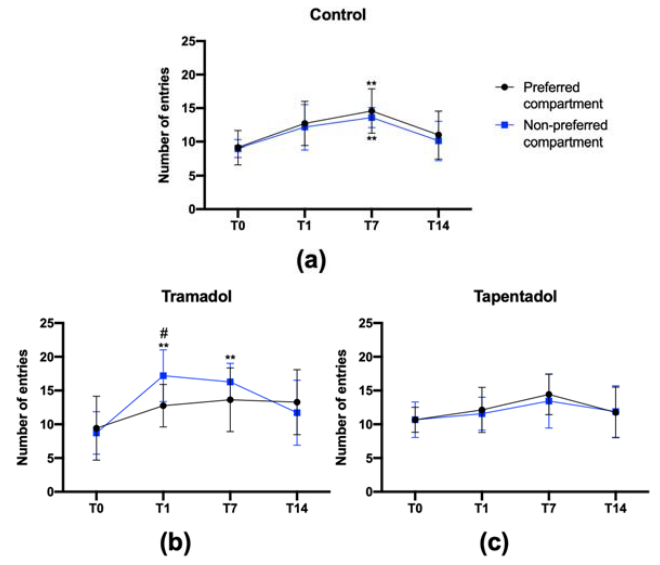
Figure 3. Number of entries in each compartment (preferred (saline-paired) compartment and non- preferred (drug-paired) compartment) at each time point—preconditioning phase (T0), and 1, 7 and 14 days after the last drug administration (T1, T7 and T14, respectively). In the conditioning phase, rats received daily intraperitoneal injections of 50 mg/kg tramadol ( b ) or tapentadol ( c ), alternating with normal saline, for 8 days. Control animals received daily intraperitoneal injections of normal saline for the same period ( a ). Results were recorded with the PPCWIN software, version 2.0 (Panlab, ref. 76-0011), and are expressed as means ± SD ( n = 9). ** p < 0.01 compared with T0; # p < 0.05 between the preferred and non-preferred compartment (same time